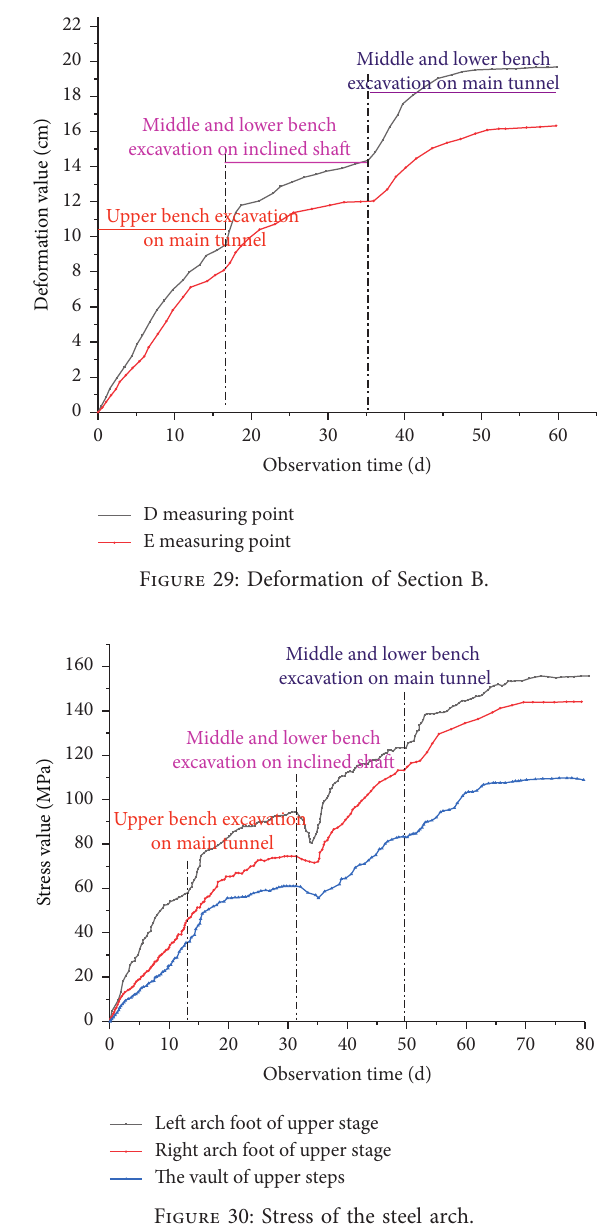
Figure 30: Stress of the steel